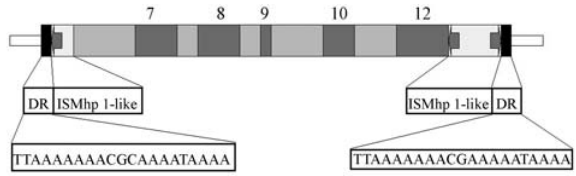
Figure 2 - The 25 kb region supposed horizontally transferred to M. synoviae. The ISMhp1-like elements are flanking the sequence and the DRs are present in the extremity of the region. The regions marked as 7, 8, 9, 10 and 12 correspond to those described by Vasconcelos et al (2005). The genomic positions of these regions are: 7 (533311); 8 (535709); 9 (537179); 10 (546230); 12 (693080). The regions 7 to 10 correspond to CDS to conserved hypothetical proteins and 12 to an ISMhp1-like ele-